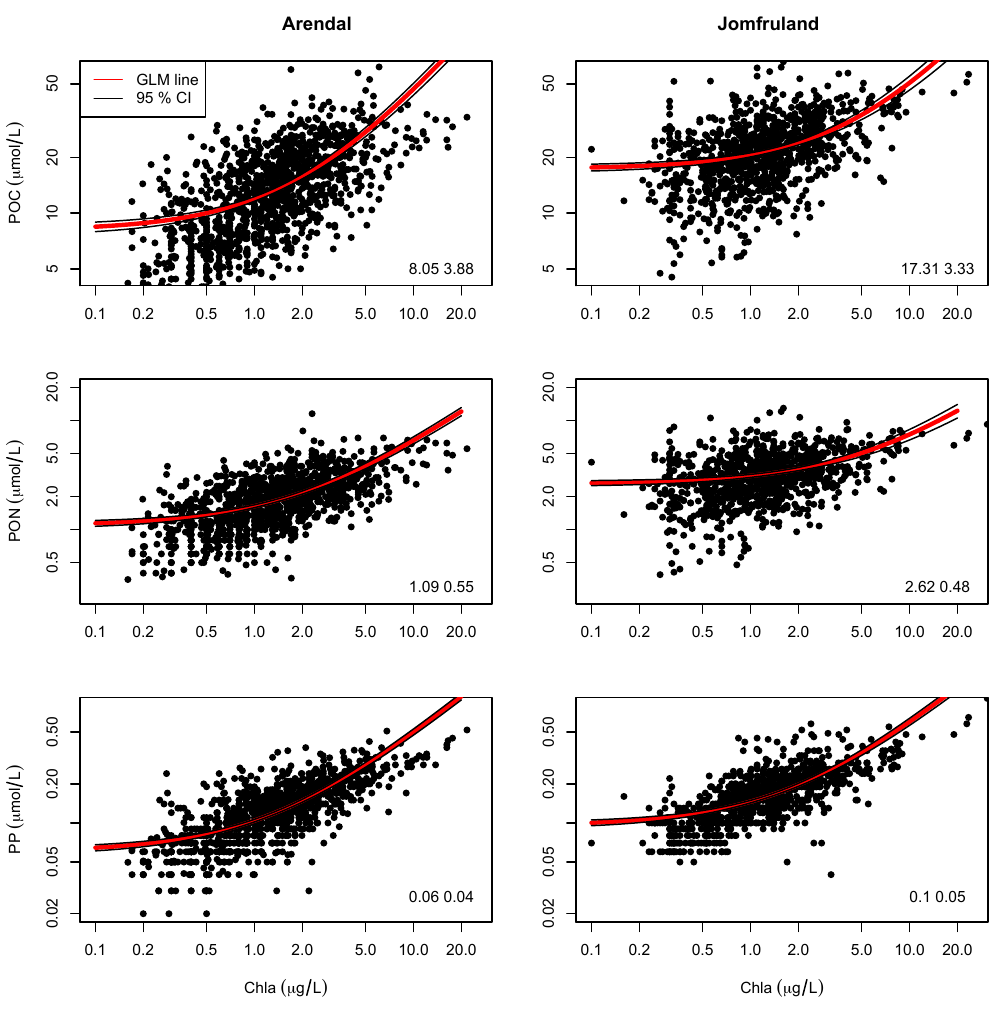
Fig. 7. Panel with POC, PON and PP vs. Chl- a for Arendal and Jomfruland with regression line (GLM with Gamma distribution and identity link) and upper and lower 95% CI. Intercept and slope of the regression lines are shown in the right corner. The seston concentrations are in µmoll − 1 and Chl- a in µgl − 1 . Please note that the x and y-axes are log-scaled (not the data).